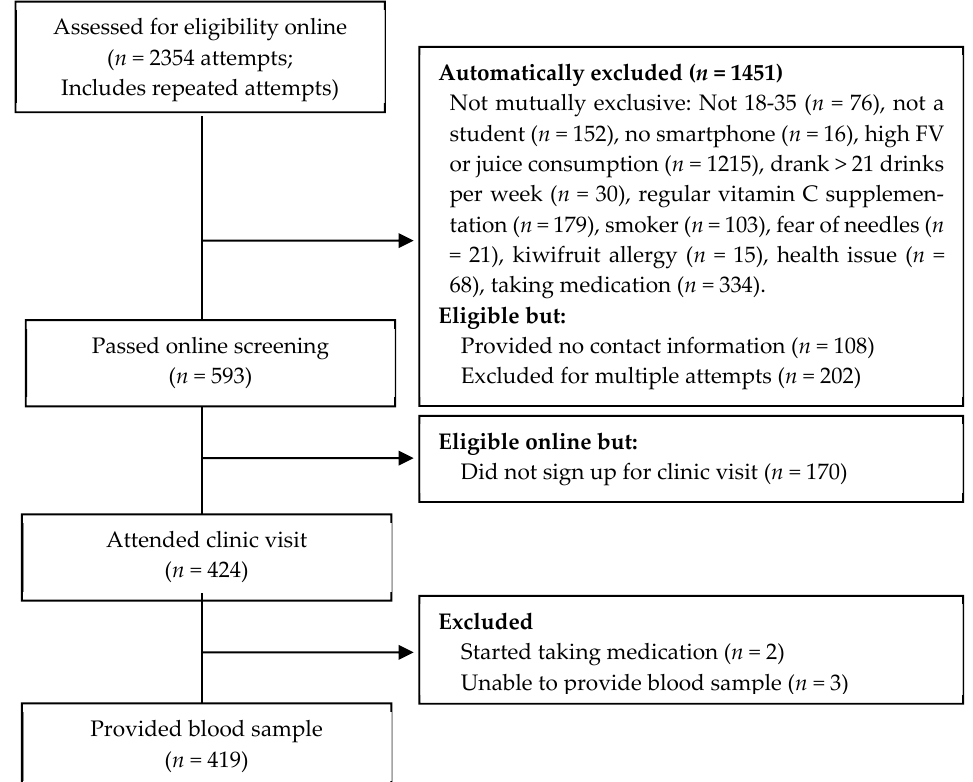
Figure 1. Participant flow diagram.